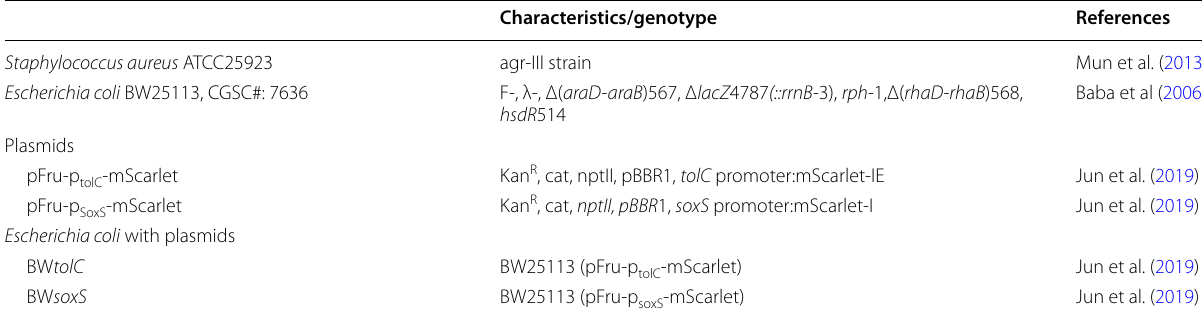
Table 1 Bacterial strains used in this